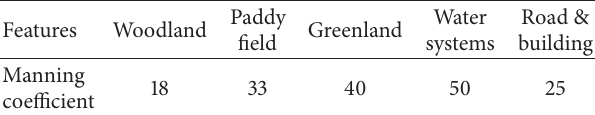
Table 2: The empirical value of roughness of different land use types given by the FloodArea model user’s manual [9].